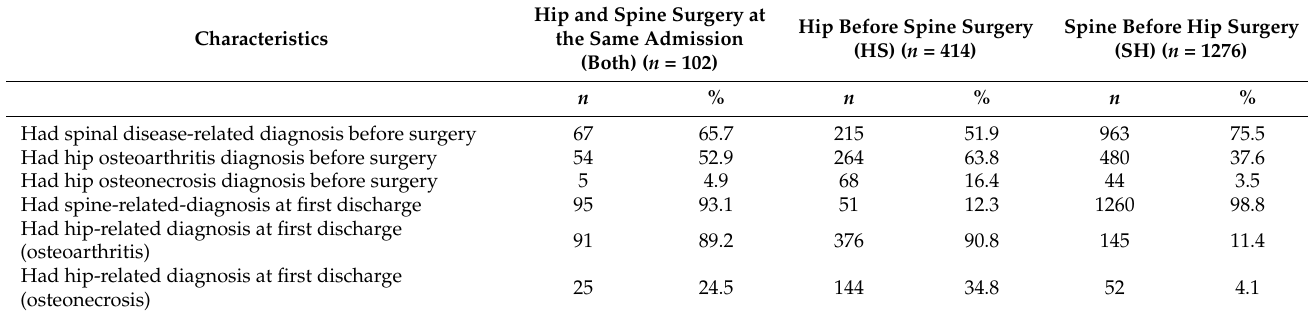
Table 4. Comparison of the diagnoses of spine or hip disorders in each group.